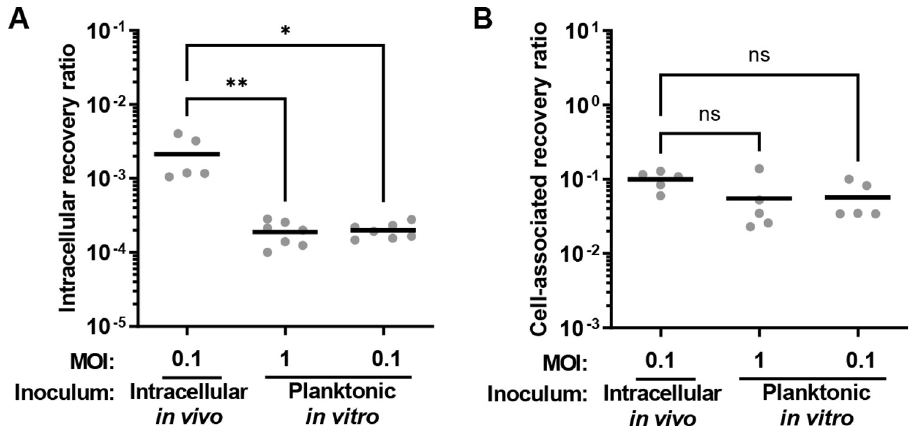
Fig 8. Increased recovery of internalized E . faecalis upon reinfection of keratinocytes by intracellular bacteria. Intracellular bacteria were isolated from infected keratinocytes and used as the inoculum (intracellular in vivo ) for reinfection of new monolayers of keratinocytes. Parallel infections at various MOI were performed using E . faecalis not yet exposed to keratinocytes, grown planktonically in vitro as the inoculum. (A) Infections proceeded for 3 h followed by 1 h of antibiotic exposure to kill the extracellular bacteria prior to intracellular CFU enumeration. (B) Infections proceeded for 3 h prior extensive washing to remove non-adhered extracellular bacteria, prior to enumeration of total cell-associated (both extracellular adhered and intracellular) CFU. Each circle represents CFU data averaged from 3 separate wells from a single biological experiment, showing a total of 5–7 independent experiments. Data are represented in the figure as the recovery ratio, which for (A) intracellular is the CFU recovered divided by the inoculum CFU and for (B) cell-associated is the CFU recovered divided by the non-cell-associated extracellular CFU in the same well, to account for cell growth during the assay. Horizontal black line indicates the mean for each condition. � p < 0.05, �� p < 0.01 Kruskal Wallis test with Dunn’s post test.